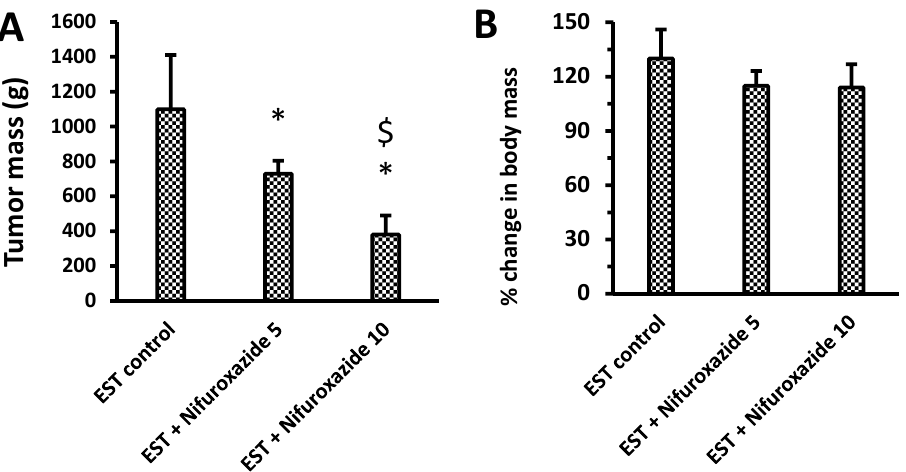
Figure 3. Impact of nifuroxazide treatment on solid tumor masses and percentage change in body masses. ( A ) tumor mass & ( B ) % change in body mass. Data are mean ± SD and evaluated by one-way ANOVA and Bonferroni’s test at p < 0.05 ( n = 6). * Versus the EST control, $ Versus the EST + Nifuroxazide (5 mg/kg) group.